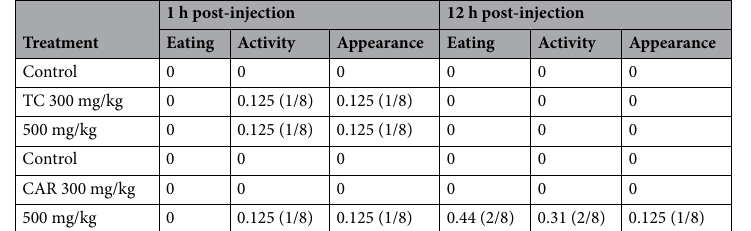
Table 4. The averaged behavior scores and the number of animals receiving a score of > 0 during the first 12 h of TC and CAR treatments. No animals treated with EU received scores of > 0.